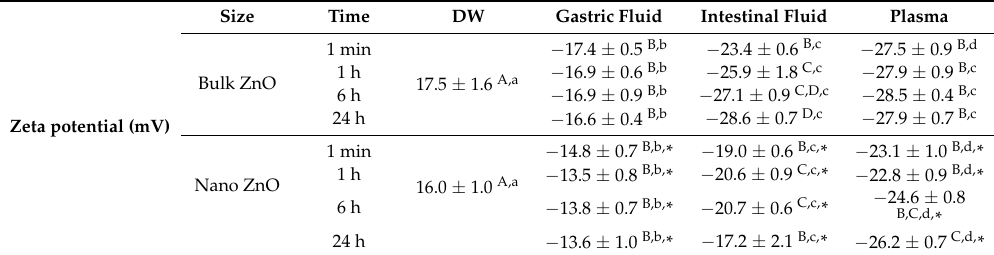
Table 2. Zeta potentials of bulk and nano ZnOs in different simulated biological fluids.